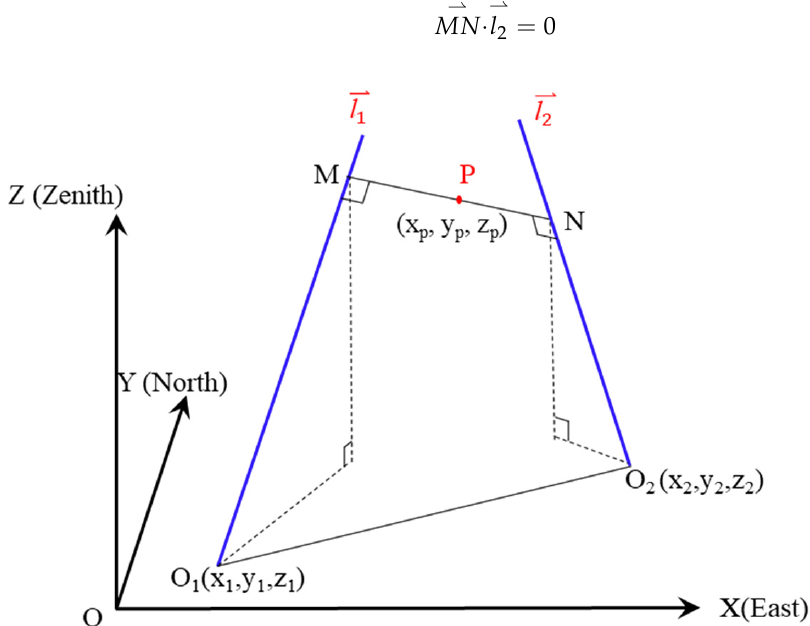
Figure 1. Schematic diagram of the three-dimensional location method.